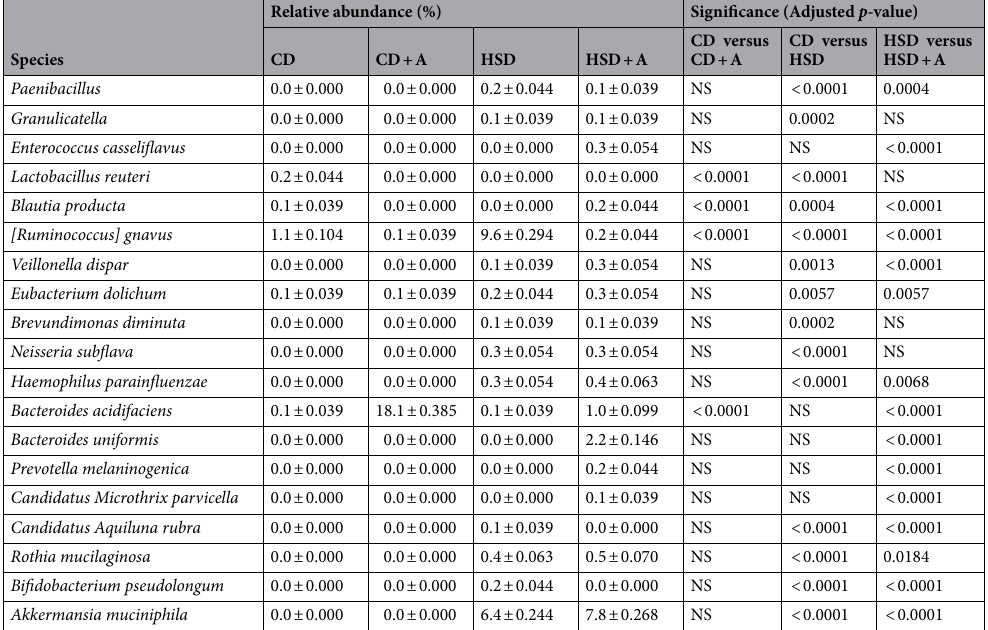
Table 8. Short term effect of high-salt (4% in chow) diet followed by Amoxicillin treatment on the mean relative abundance of major bacterial groups at the species level in mice. Values are expressed as the means ± SD. Data were analyzed by one-way ANOVA, followed by Bonferroni test, n = 6, p ≤ 0.05, NS = Not significant, CD: Standard—chow diet for 3 weeks; CD + A: Standard—chow diet for 3 weeks and subjected to Amoxicillin treatment in 3rd week; HSD: High-salt diet for 3 weeks; HSD + A: High-salt diet for 3 weeks and subjected to Amoxicillin treatment in 3rd